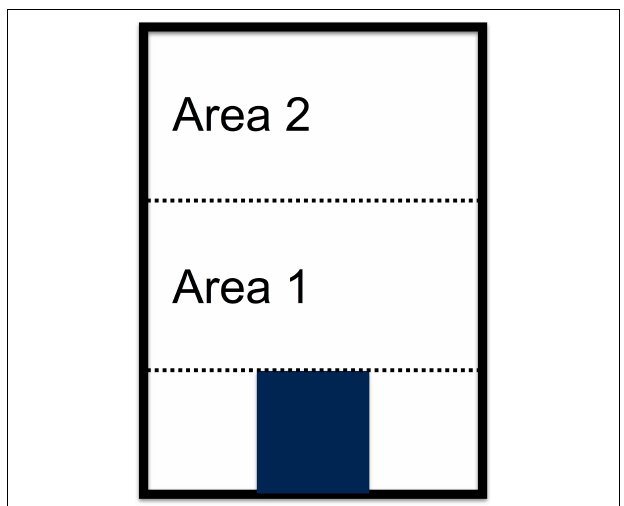
FIGURE 1 | Diagram of arena used in the experiment. The blue rectangle in the bottom section represents the nest area. Dotted lines represent barriers that were opened from the outside. The data reported here compare ant behavior in Area 1 and Area 2, before and after the barrier was opened that separated Area 1 from Area 2.